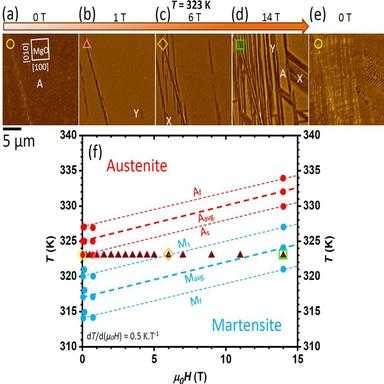
Isothermal phase transition: a-e) MFM images captured upon applying μ0H = 0.0–14.0 T parallel to MgO at 323 K, showing the formation and coalescence of the X- and Y-type twinning configurations. Direction of the MgO substrate is provided as a reference. Some of the X- and Y-type regions as well as the austenitic areas (A) are labeled. f) Temperature-magnetic field phase diagram of the sample deduced from the thermomagnetic curves 2m, Table S1 and Fig. S5). The x-axis shows the external magnetic